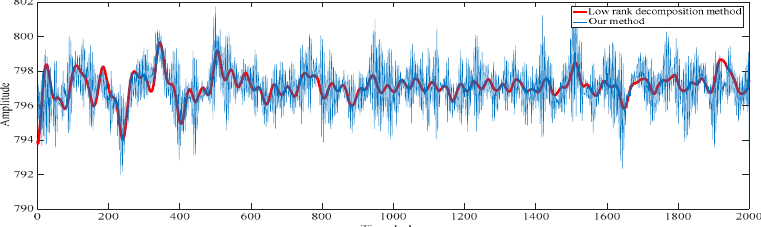
Figure 18. The electroencephalograms obtained based on our proposed method and the conventional low-rank decomposition-based method.